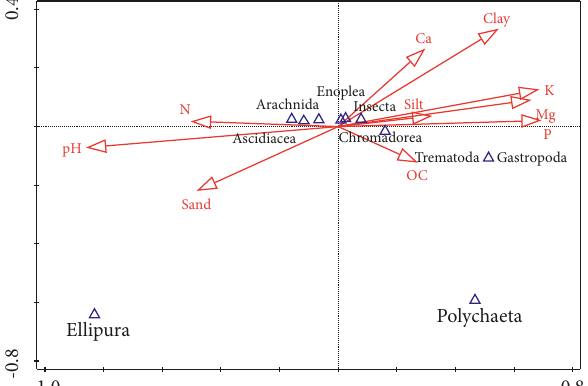
Figure 4: CCA of termite mound and adjacent soil invertebrate communities and soil physicochemical parameters. Table 3: Forward selection of environmental variables, which best explain variation in invertebrate composition among samples. Environmental parameters Explanation (%) Contribution (%) Pseudo-F p